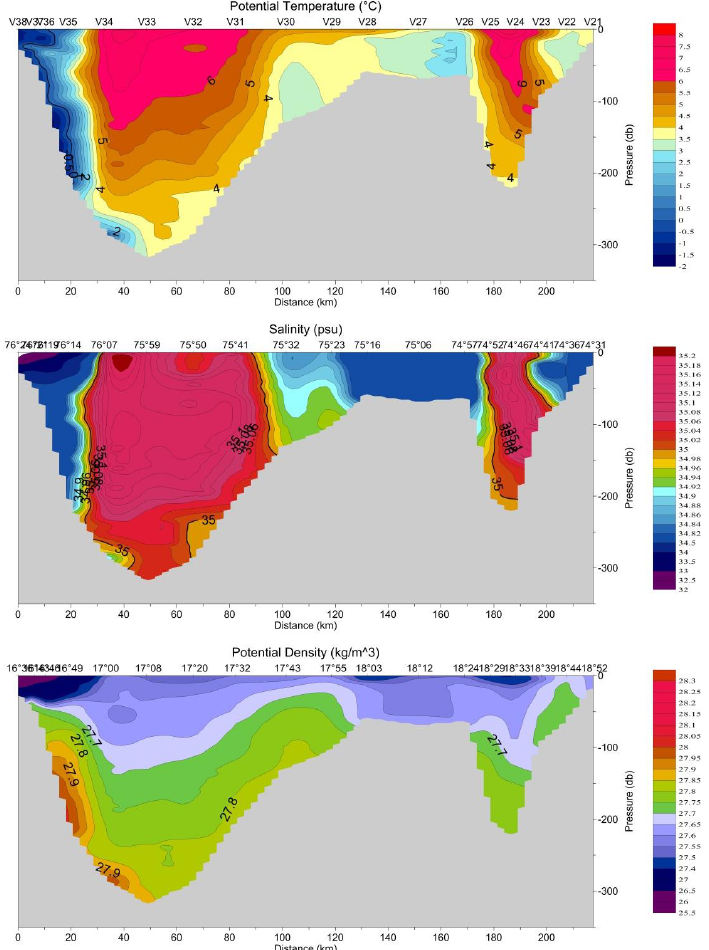
Figure 12. Section from the Sørkapp at the left hand side to Bear Island. (a) Temperature, (b) 2 Fig. 12. Section from the Sørkapp at the left-hand side to Bear Island. (a) Temperature, (b) salinity, and (c) potential density. Section V2, R/V Oceania , summer salinity, and (c) potential density. Section V2, R/V ‘Oceania’, summer 2006 3